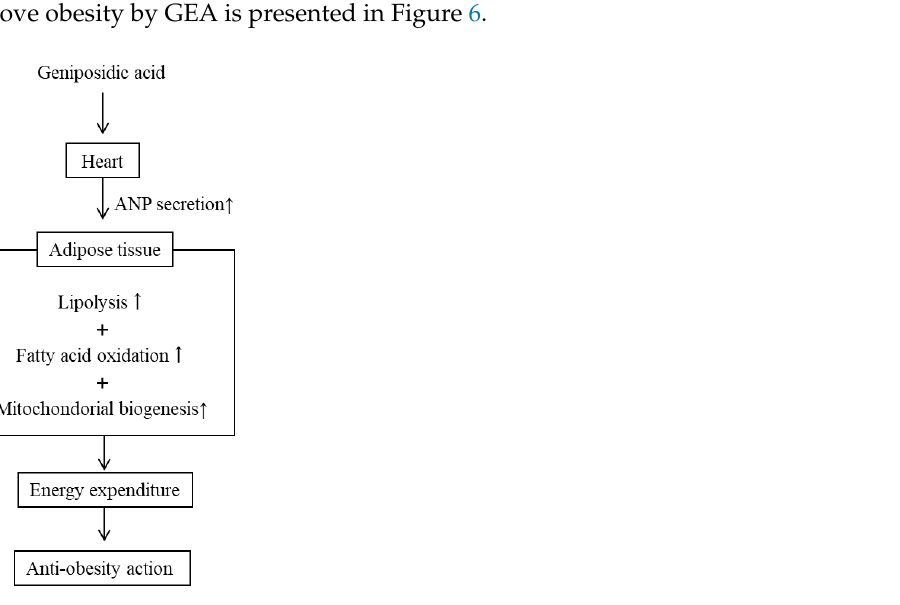
Figure 6. Anti-obesity mechanism of action of GEA through ELE treatment by ANP secretion in rodents. Small arrows next to words indicate the increases or decreases in the action or secretion.